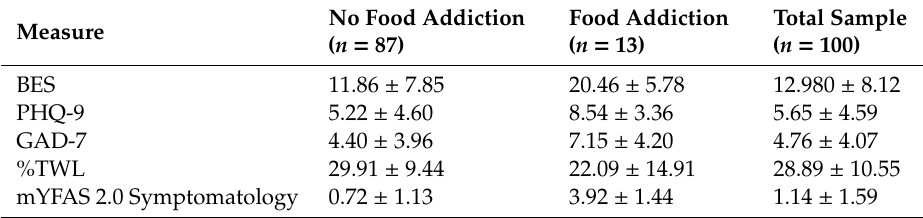
Table 3. Clinical characteristics of patients with food addiction (according to the mYFAS2.0), patients without food addiction, and the total sample assessed at 1 year post-surgery. Values represent mean ± standard